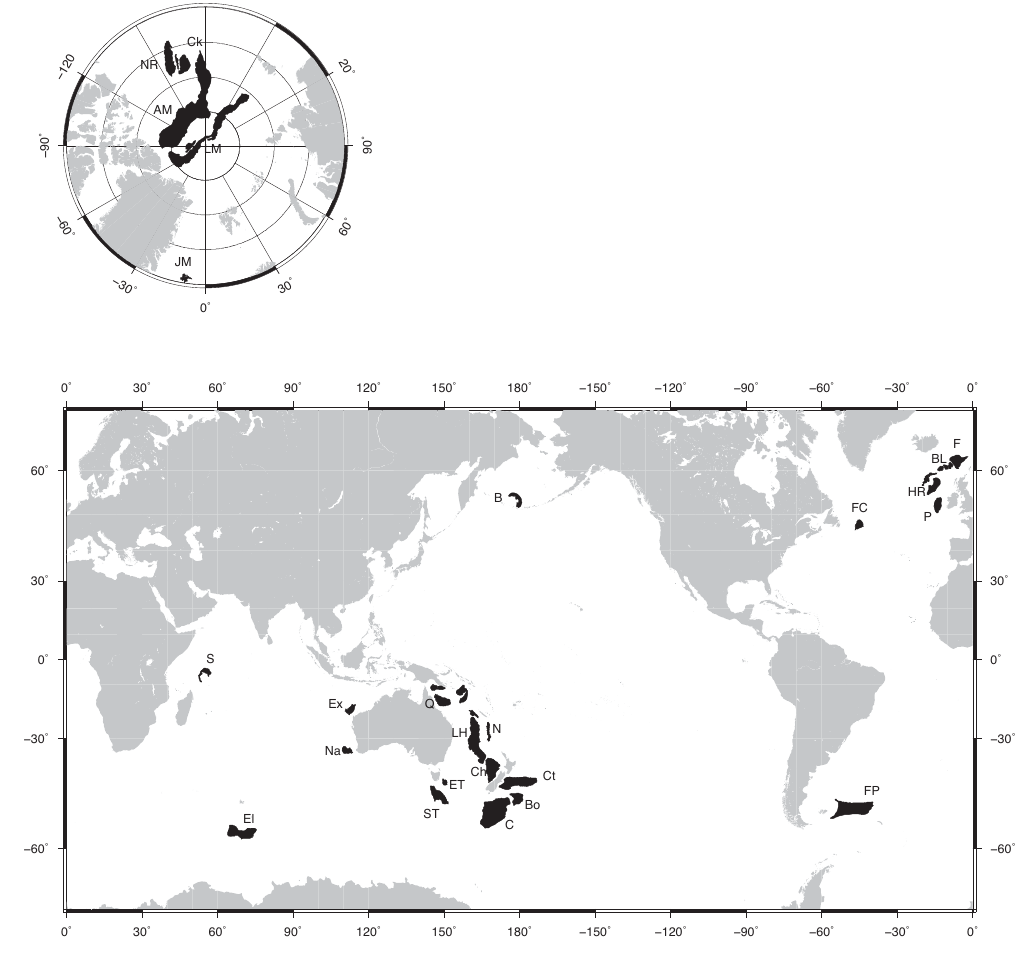
Figure 7. Location map of continental fragments (shown in black) compiled for this study. Continental fragments labeled are: AM – Alpha Mendelev Ridge, B – Bower’s Ridge, Bo – Bounty Plateau, BL – Bill Bailey and Lousy banks, C – Campbell Plateau, Ch – Challenger Plateau, Ck – Chukchi Plateau, Ct – Chatham Rise, El – Elan Bank, Ex – Exmouth Plateau, ET – East Tasman Plateau, F – Faroe Bank, FC – Flemish Cap, FP – Falkland Plateau, HR – Hatton and Rockall Banks, JM – Jan Mayen, LH – Lord Howe Rise, LM – Lomonosov Ridge, Na – Naturaliste Plateau, N – Norfolk and Fairway Ridges, NR – Northwind Ridge, P – Porcupine Bank, Q – Queensland Plateau, S – Seychelles, and ST – South Tasman